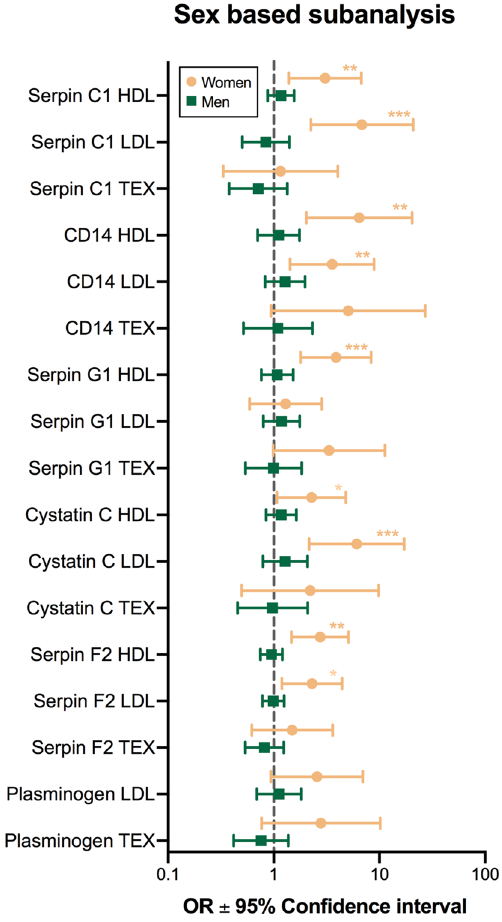
Figure 2. Forestplot of multivariable logistic regression subanalysis stratified on sex. Horizontal bars indicate adjusted* odds ratios and corresponding 95% CI for ischemia. Biomarker levels are log-transformed and standardized per synthetic vesicle. Original assay units are pg/ml. *Adjusted for: age, hypertension, smoking, hypercholesterolemia, diabetes mellitus and coronary artery